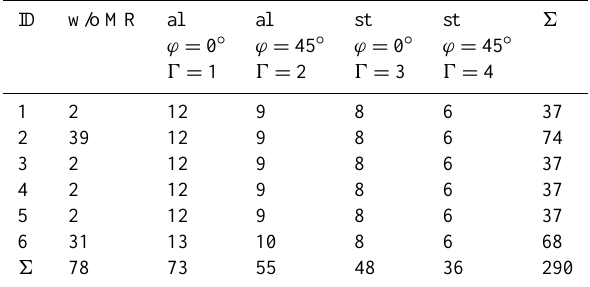
Table 2. Number of conducted experiments classified according to the utilized wave properties listed in Table 1 and to the MR combi- nations 0 , “al” aligned, “st”’